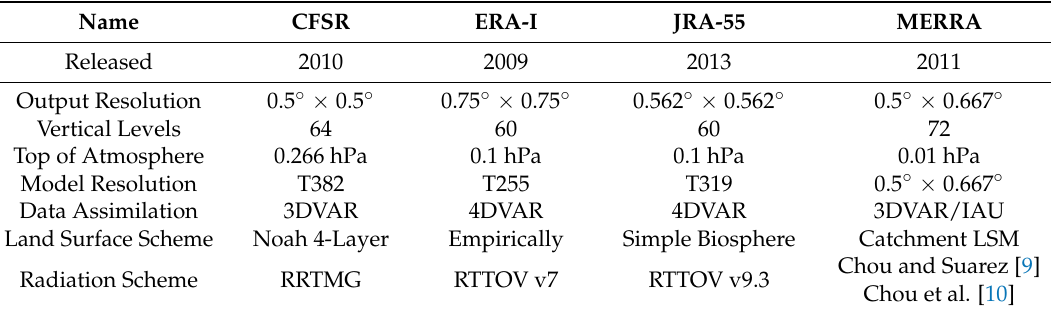
Table 1. Summary of reanalysis models used for ensemble. Major differences between each reanalysis model shown